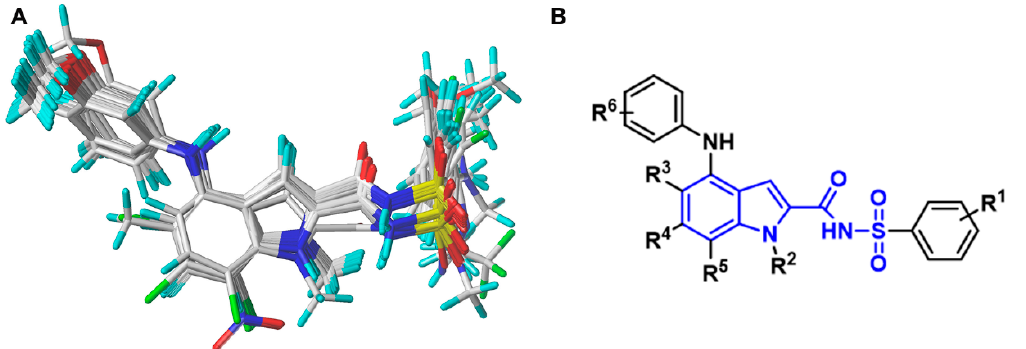
Figure 9. Molecular alignment of the 3D-QSAR models. ( A ) The alignment result of all the training set molecules. ( B ) The common skeleton (blue) of N -arylsulfonyl-indole-2-carboxamides used for the alignment.